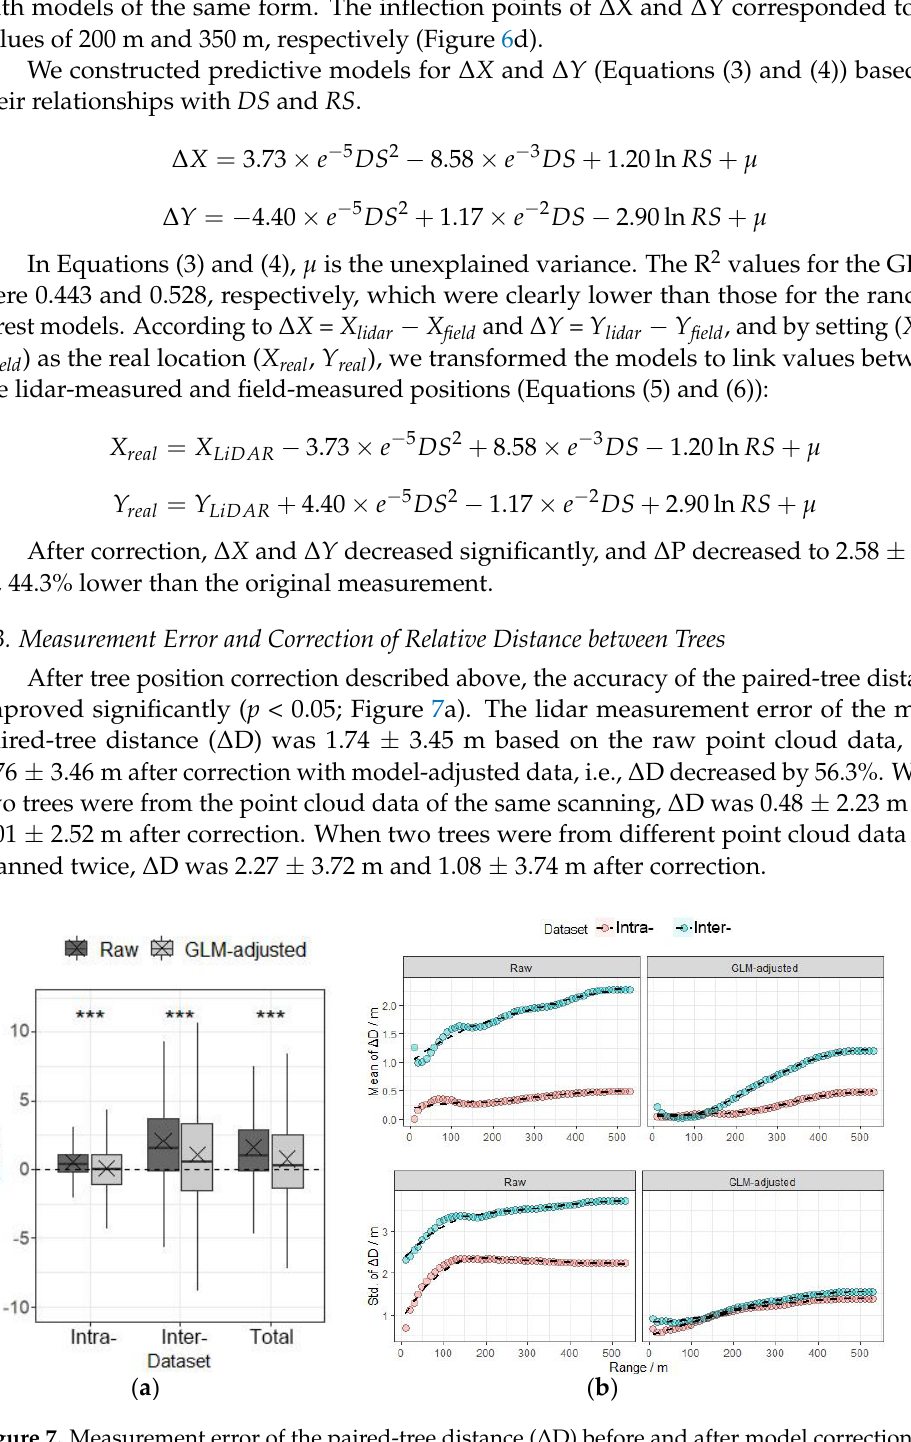
Table 2. Curve fitting for the marginal response of the ΔP values to the primary predictive varia- bles. The table shows the F value and R 2 value for the models.